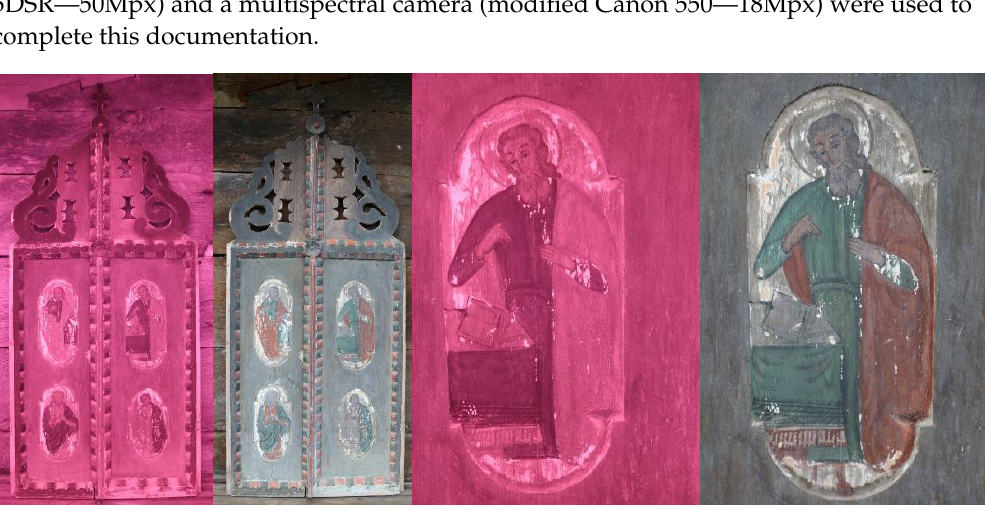
Figure 7. Photographs of Imperial Gates in the visible and IR spectrum. In Figure 7, the first two images provide an overview of the whole artefact, while the last two showcase a close-up on the top right area.